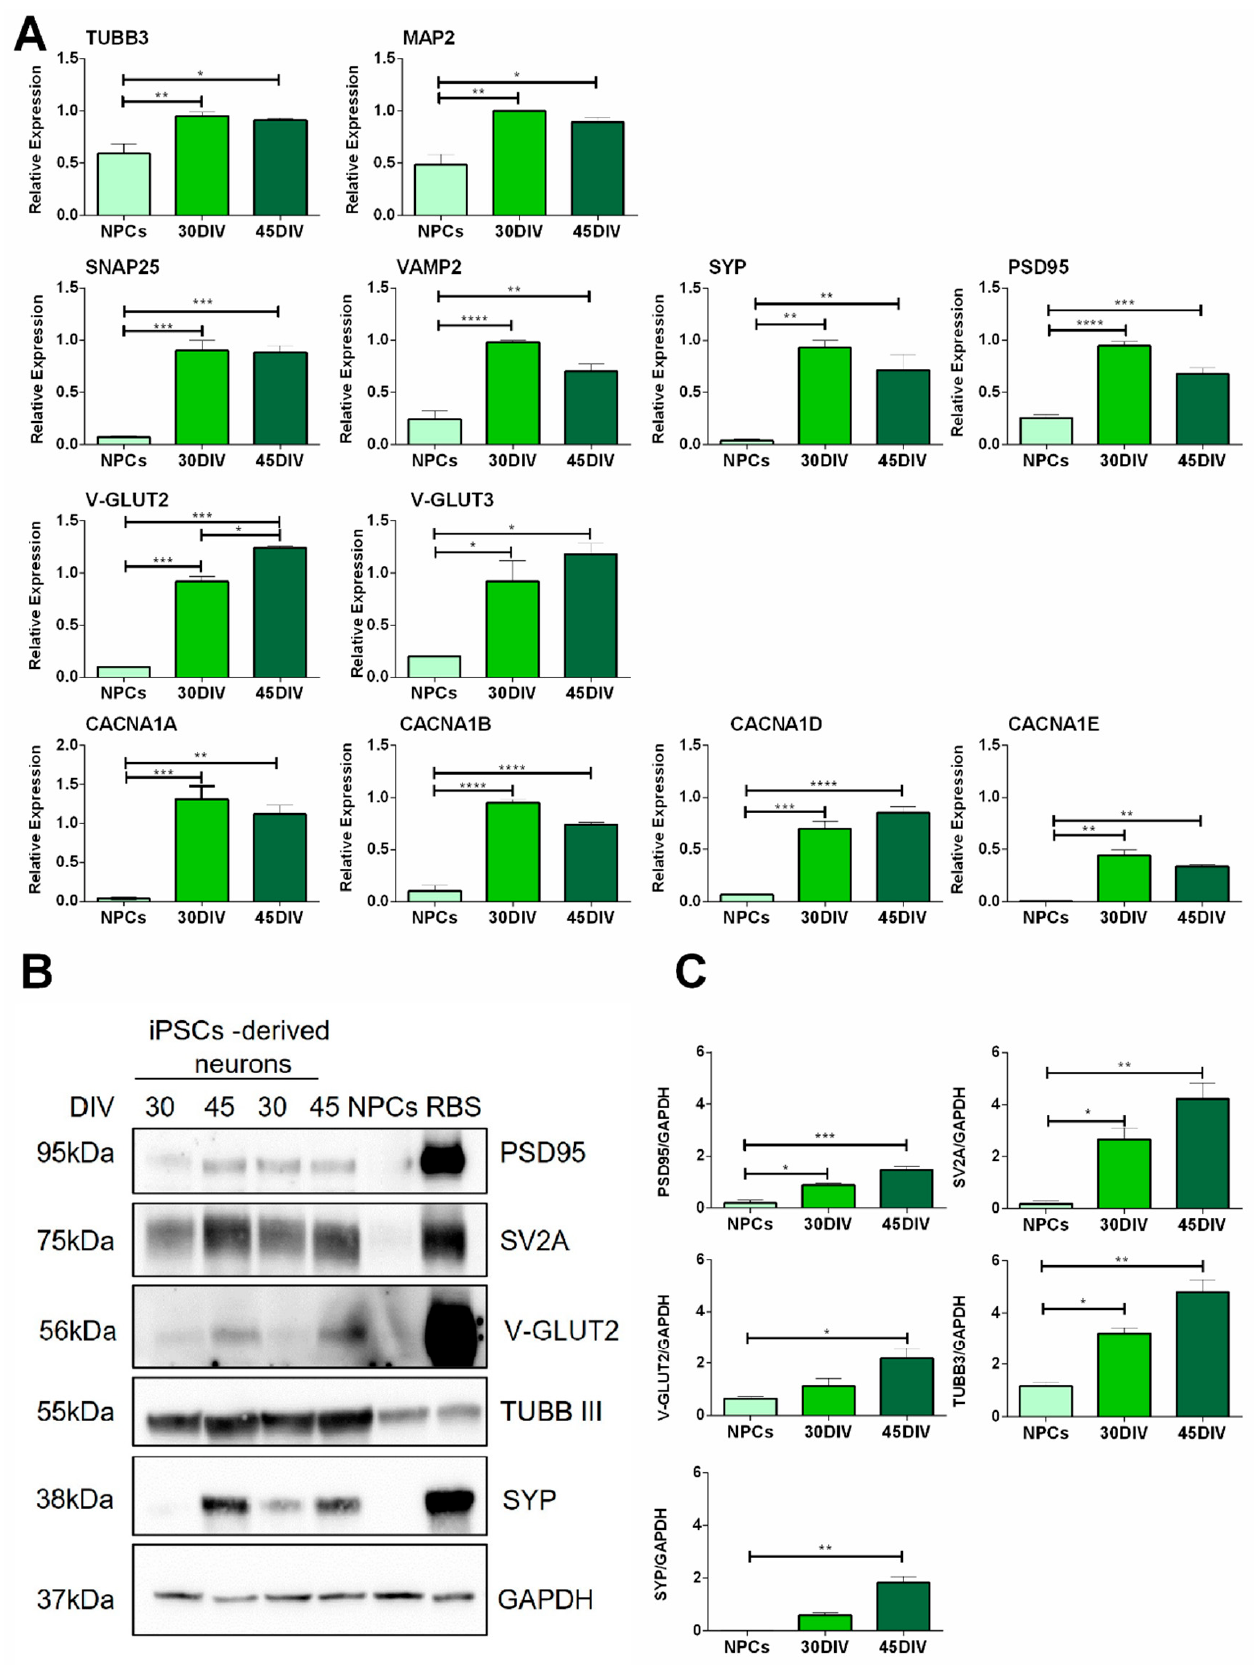
Figure 2. hiPSC-derived neurons express neuronal markers. ( A ) Gene expression profiling of hiPSC-derived neurons by qRT-PCR showing upregulation of neuronal markers in neurons at mature stages (30–45 days of differentiation in vitro (DIV)). Neuronal markers: Tubulin Beta 3 Class III (Tubb3 ) , Microtubule-associated protein 2 (Map2 ) ; synaptic markers: Synaptosome Asso- ciated Protein 25 ( Snap25) (pre-synaptic), Vesicle Associated Membrane Protein 2 ( Vamp2 ) (pre-synaptic), Synaptophysin ( Syp ) (pre-synaptic), Discs Large MAGUK Scaffold Protein 4 (Postsynaptic density protein 95) (Psd95) (post-synaptic); Vesicular Glutamate Transporters type: